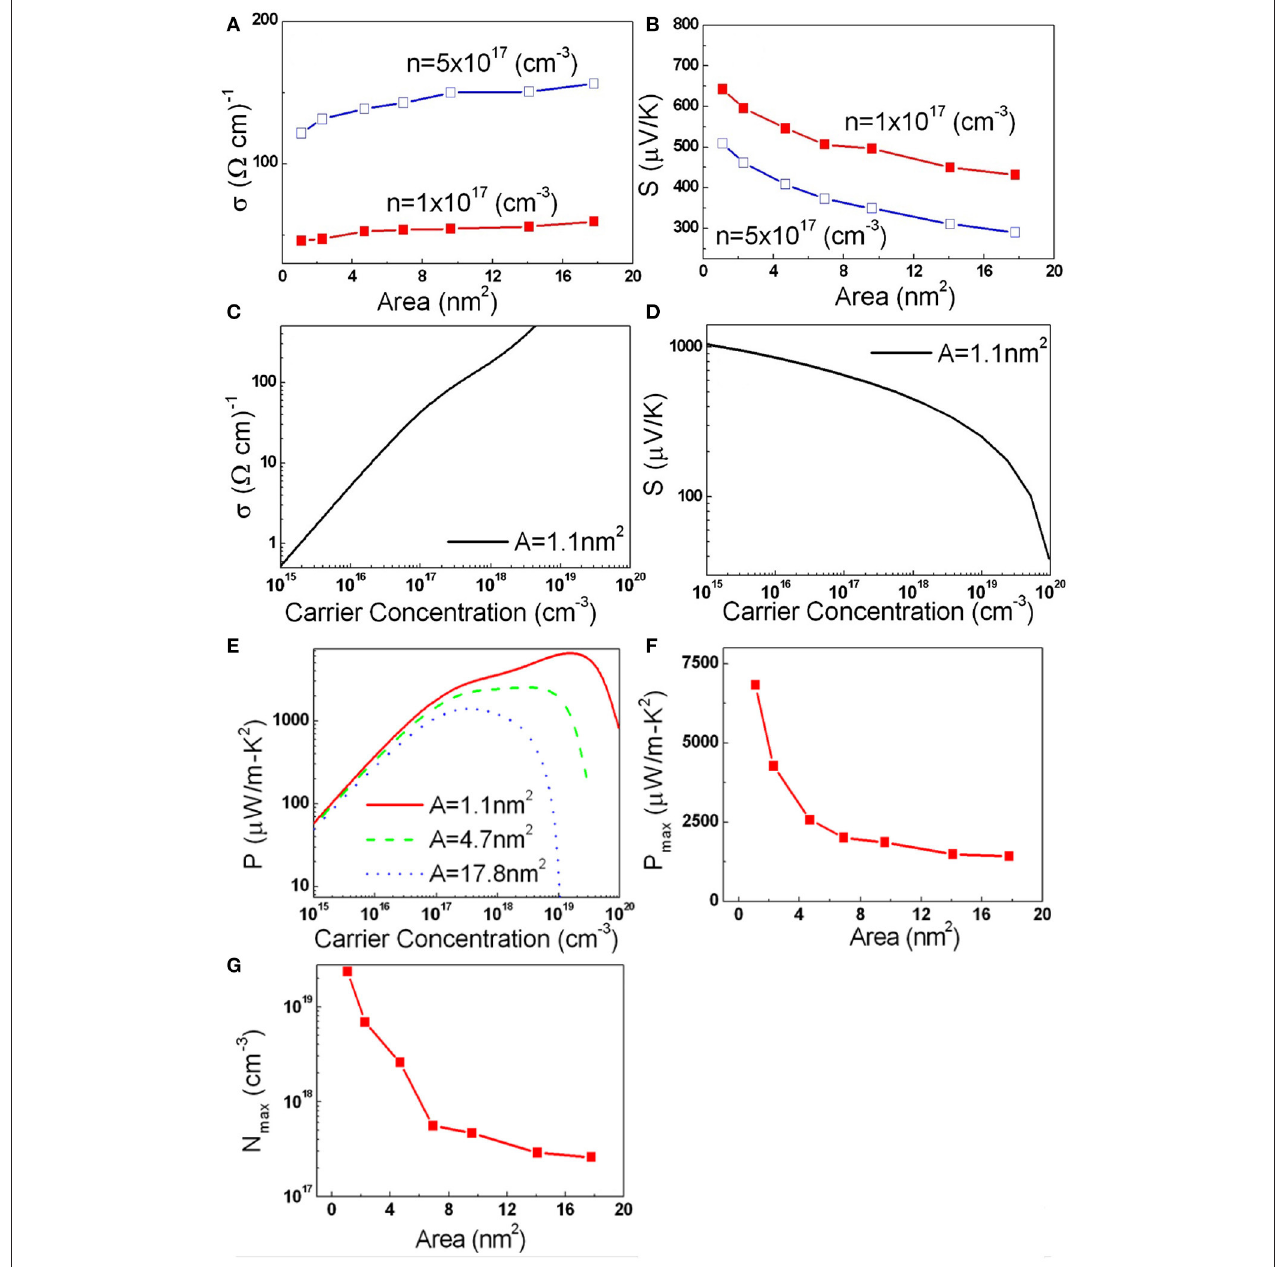
FIGURE 5 | (A–D) S , σ vs. area, n ; (E–G) PF (P), optimal PF (Pmax), optimal carrier concentration (Nmax) vs. area, n . Reprint from Shi et al.